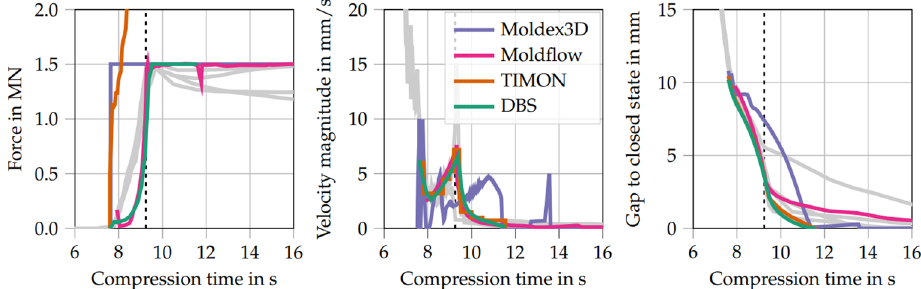
Figure 13. Press data from several parts molded with Configuration B (gray) compared with the numerical compression profiles predicted by M OLDEX 3D (purple) and M OLDFLOW (pink), 3D TIMON (orange), Direct Bundle Simulation (green). The dashed lines indicate the switch from displacement control to force